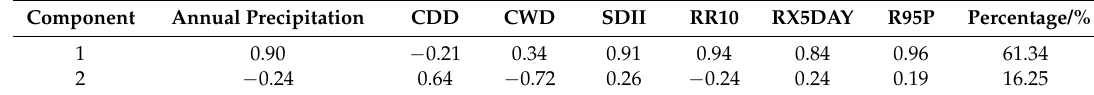
Table 4. Factor analysis of extreme precipitation indices.